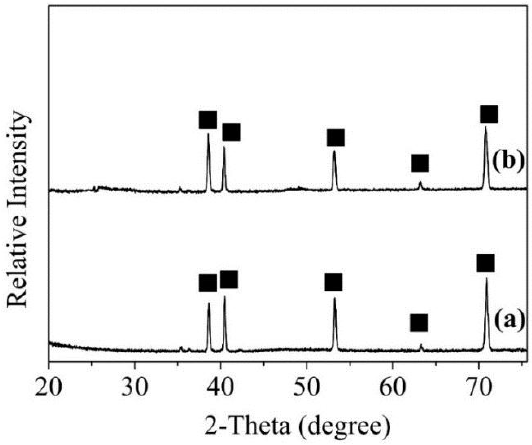
Figure 6. XRD patterns of Ti foil. ( a ) before reaction; ( b ) after reaction.